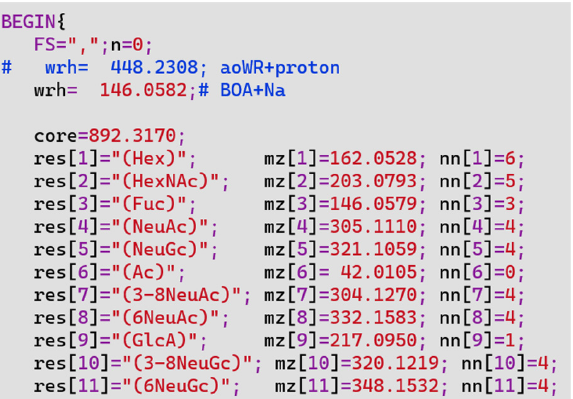
Figure 2. The beginning of the TAG List script. # means that the rest of the line is a comment. Therefore, anything after # in the same line is not executed within the program.